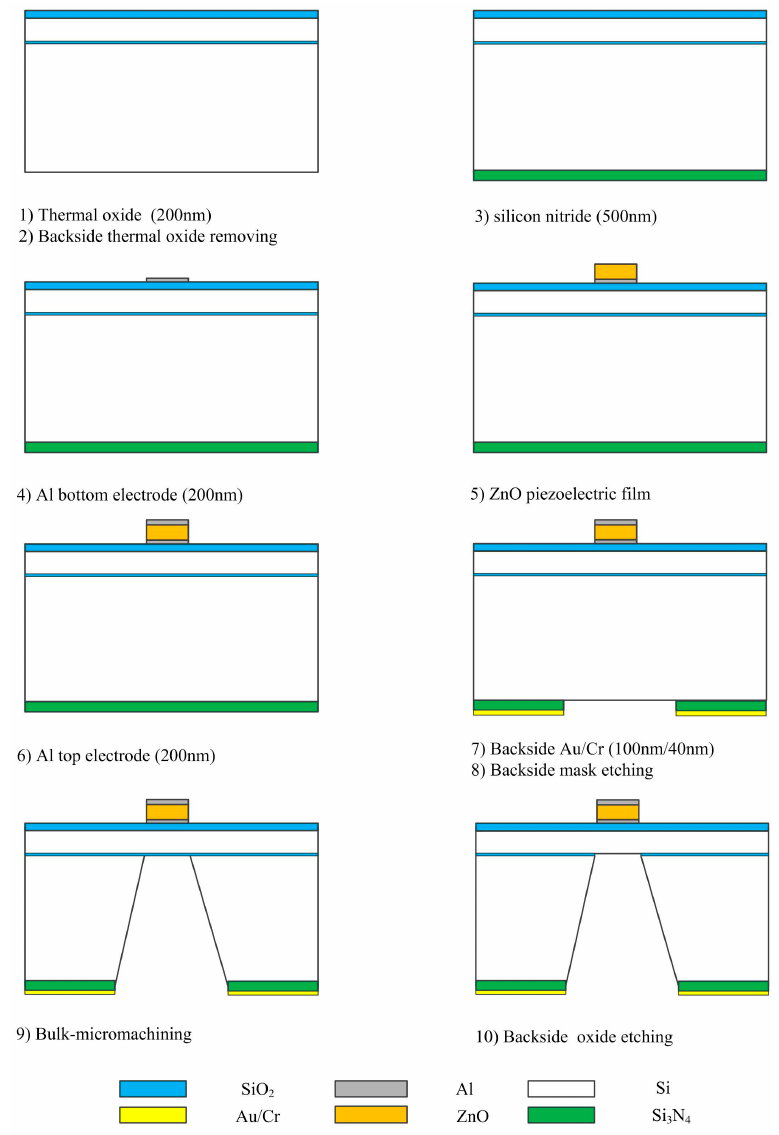
Figure 9. Fabrication process of the pMUT.